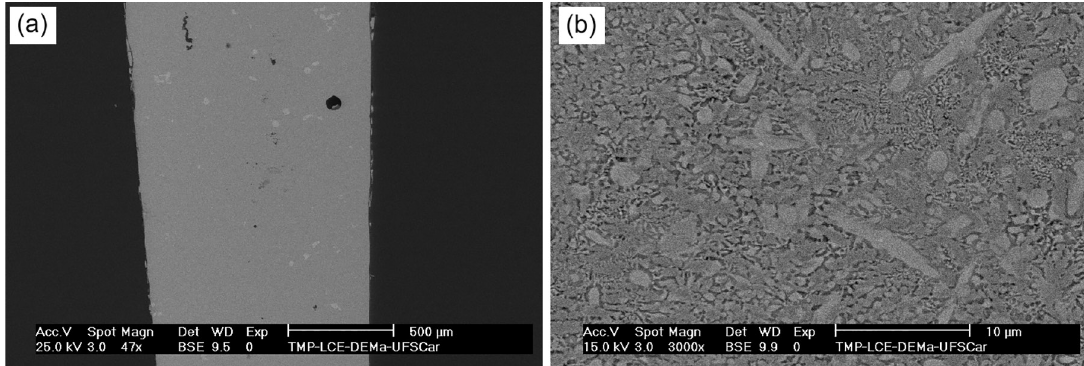
Cr Nb B alloy; (b) 58 10 8 24